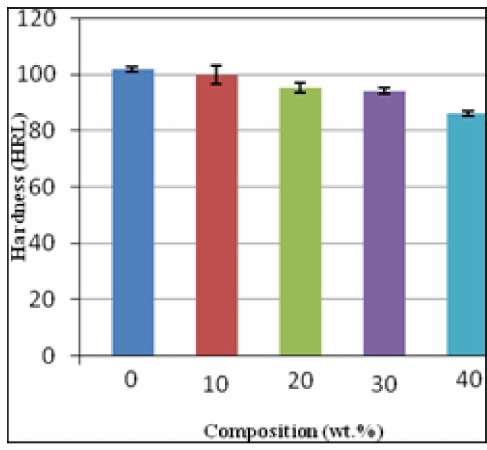
Figure 8: Variation of hardness with rice husk content [39]